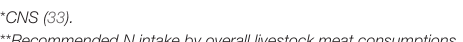
( Figure 1 ). The average rural per capita food NFs of 77% regions fell in the range of 13–17 kg N, and extremely higher rural per capita food NFs were found in Tibet (28.75 kg N), Xinjiang (21.17 kg N), and Qinghai (20.13 kg N), where population densities are lower compared with China. Lower average rural per capita food NFs were shown in Shaanxi (10.98 kg N),